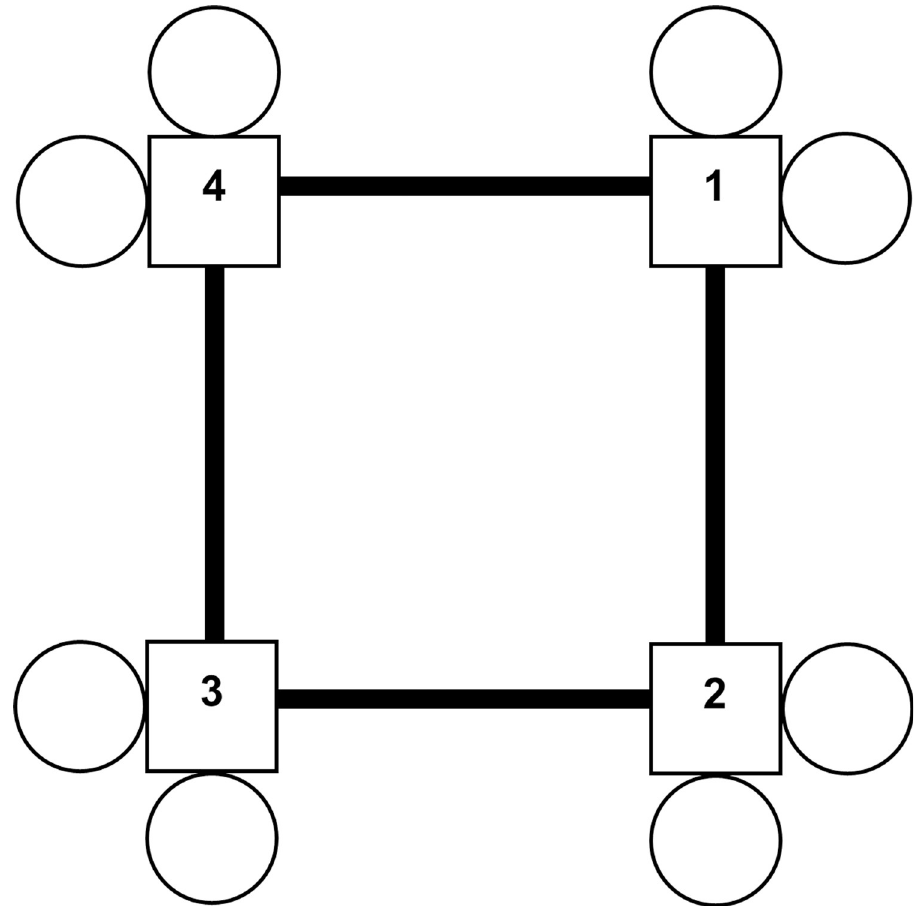
Fig 1. IntelliCage schematic. Central home cage and four labeled corners with two drinking sides per corner.